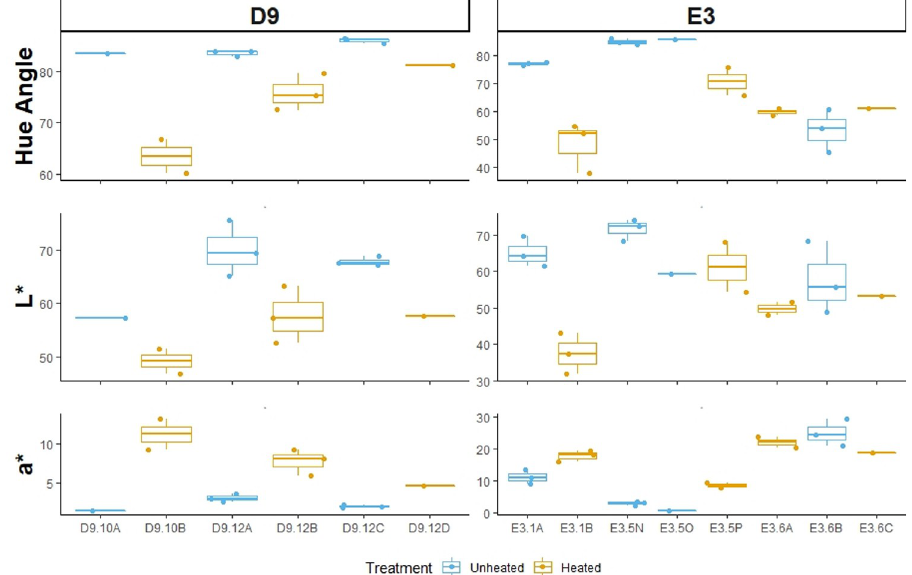
Fig 4. CIE L � a � b � variables across level of treatment by nodule. Boxplots comparing the distributions of three colorimetry variables (hue-angle, L � , a � ) between unheated and heat-treated silcrete specimens across sources D9 and E3 and within nodules. Chroma and b � were excluded from this figure because they did not show significant differences between level of treatment. Source I14 was not shown in this figure because it only had one paired nodule and the intra-nodule results can be seen in Fig 3. The naming convention for the nodules seen on the x-axis is Source. Nodule. Thus, D9.10A means that the sample is nodule 10A from source